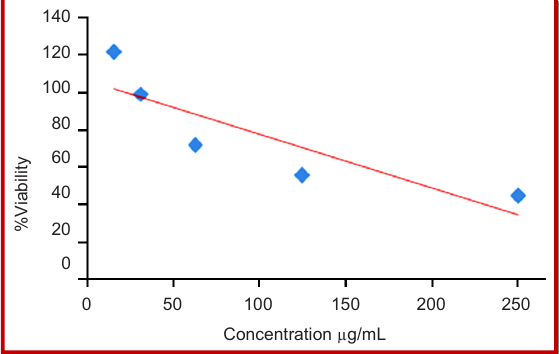
Figure 2: Concentration effect of BanLec on Vero cells. The IC 50 was calculated using regression line. Data’s were ex- pressed as mean ± SD from three independent